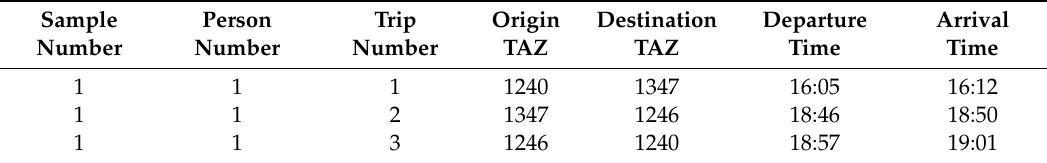
Table 2. Sample trip data from SACSIM15.